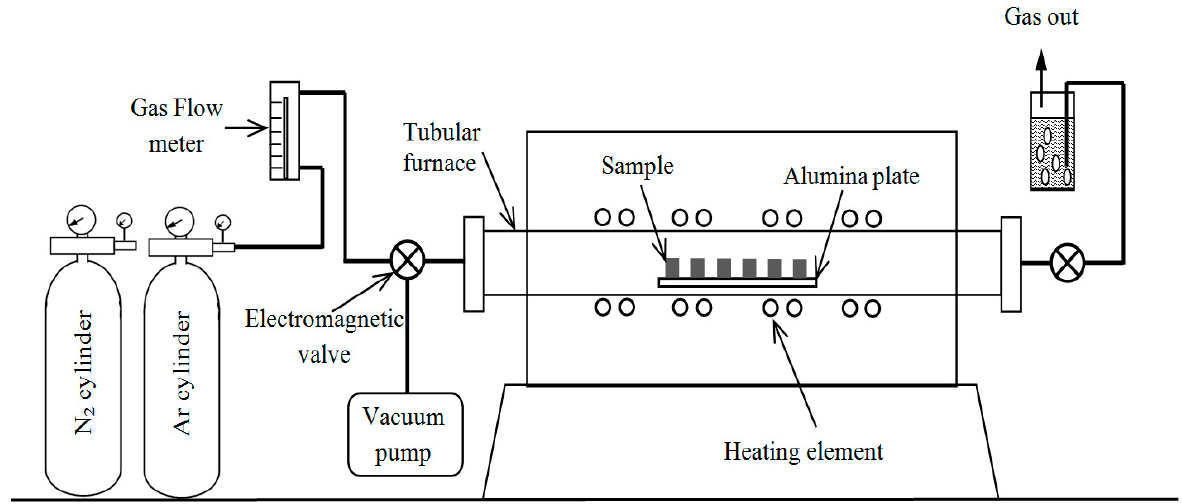
Figure 5. Schematic representation of the sintering furnace used with operating arrangement.